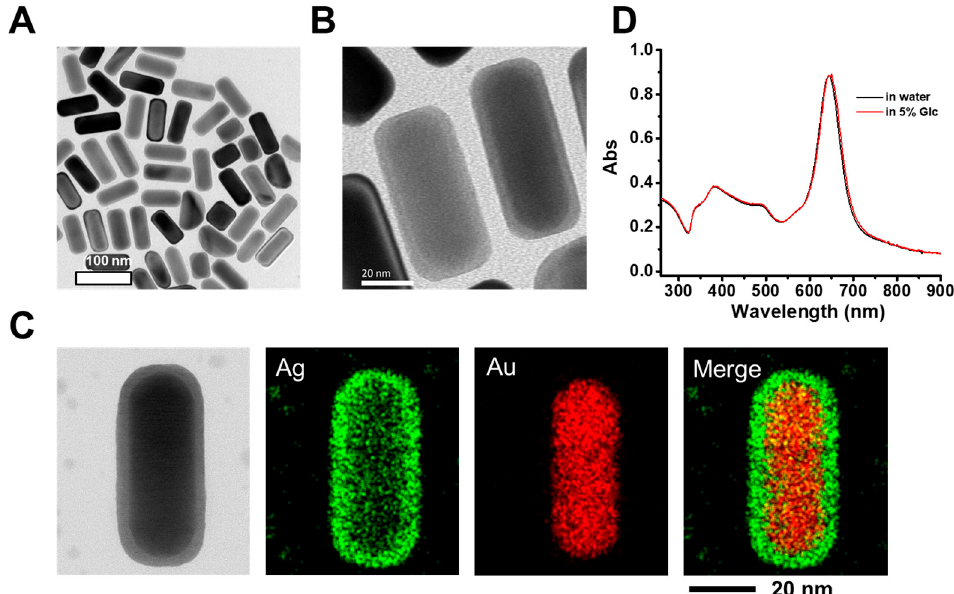
Figure 1. Characterizations of gold nanorods core/silver shell nanostructures (Au@Ag NRs). ( A and B ) Typical TEM images of Au@Ag NRs; ( C ) TEM image of an individual Au@Ag NR and